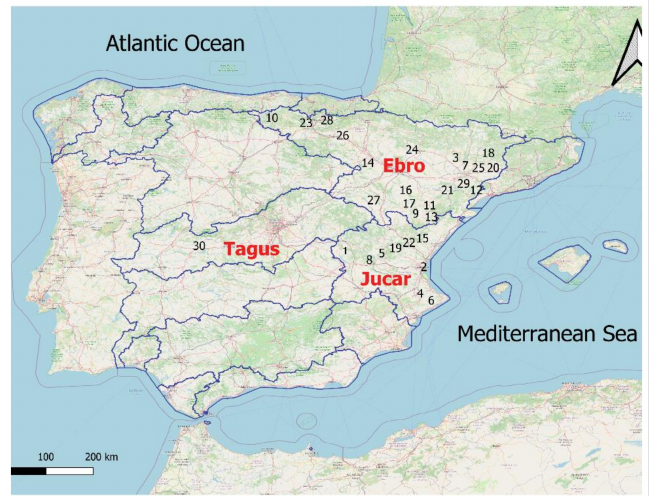
Figure 1. Map of watersheds of Spain showing the location of the reservoirs studied, the number of which coincides with that used in Table A1 of the Appendix